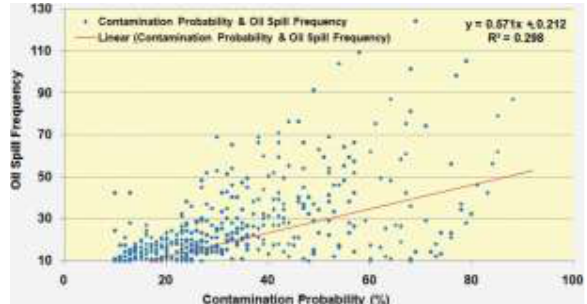
Figure 14. Caspian Sea Currents around the Oil Rocks Settlement, Chilov & Pirallahi Islands